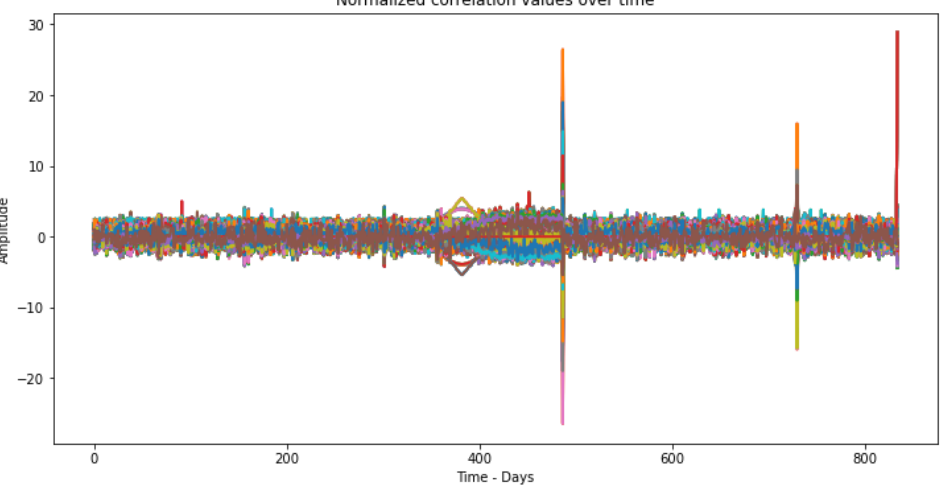
Figure 4. Correlation features normalized by Z-score over study